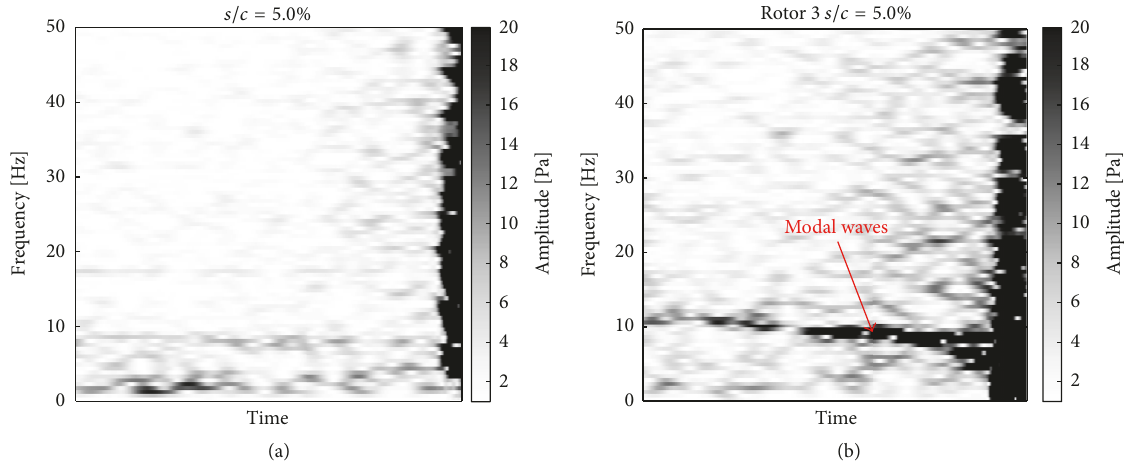
Figure 11: Spectrogram of microphone at 𝑐 Rotor 3 of four-stage